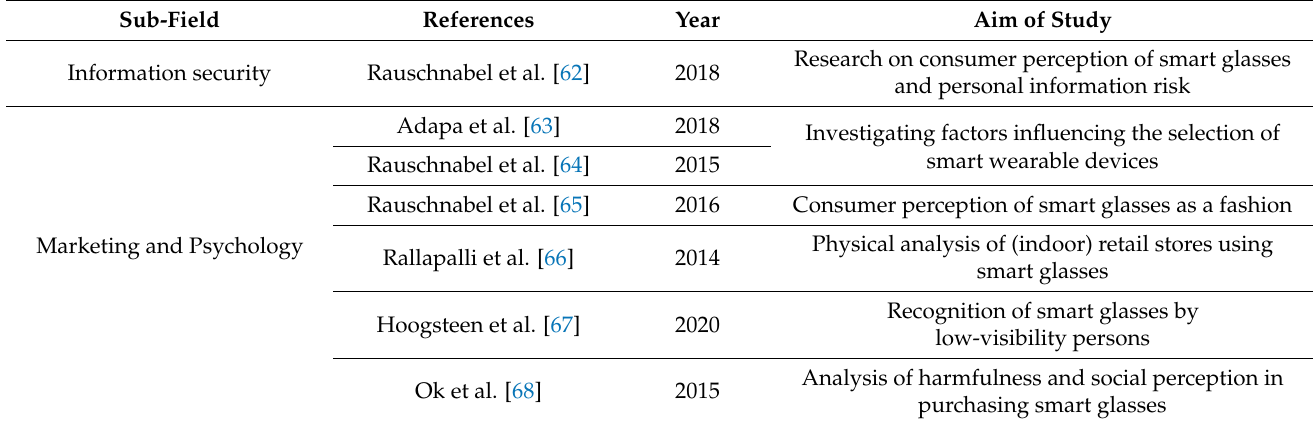
Table 6. Summary of smart glass applications in the field of social science. Sub-Field